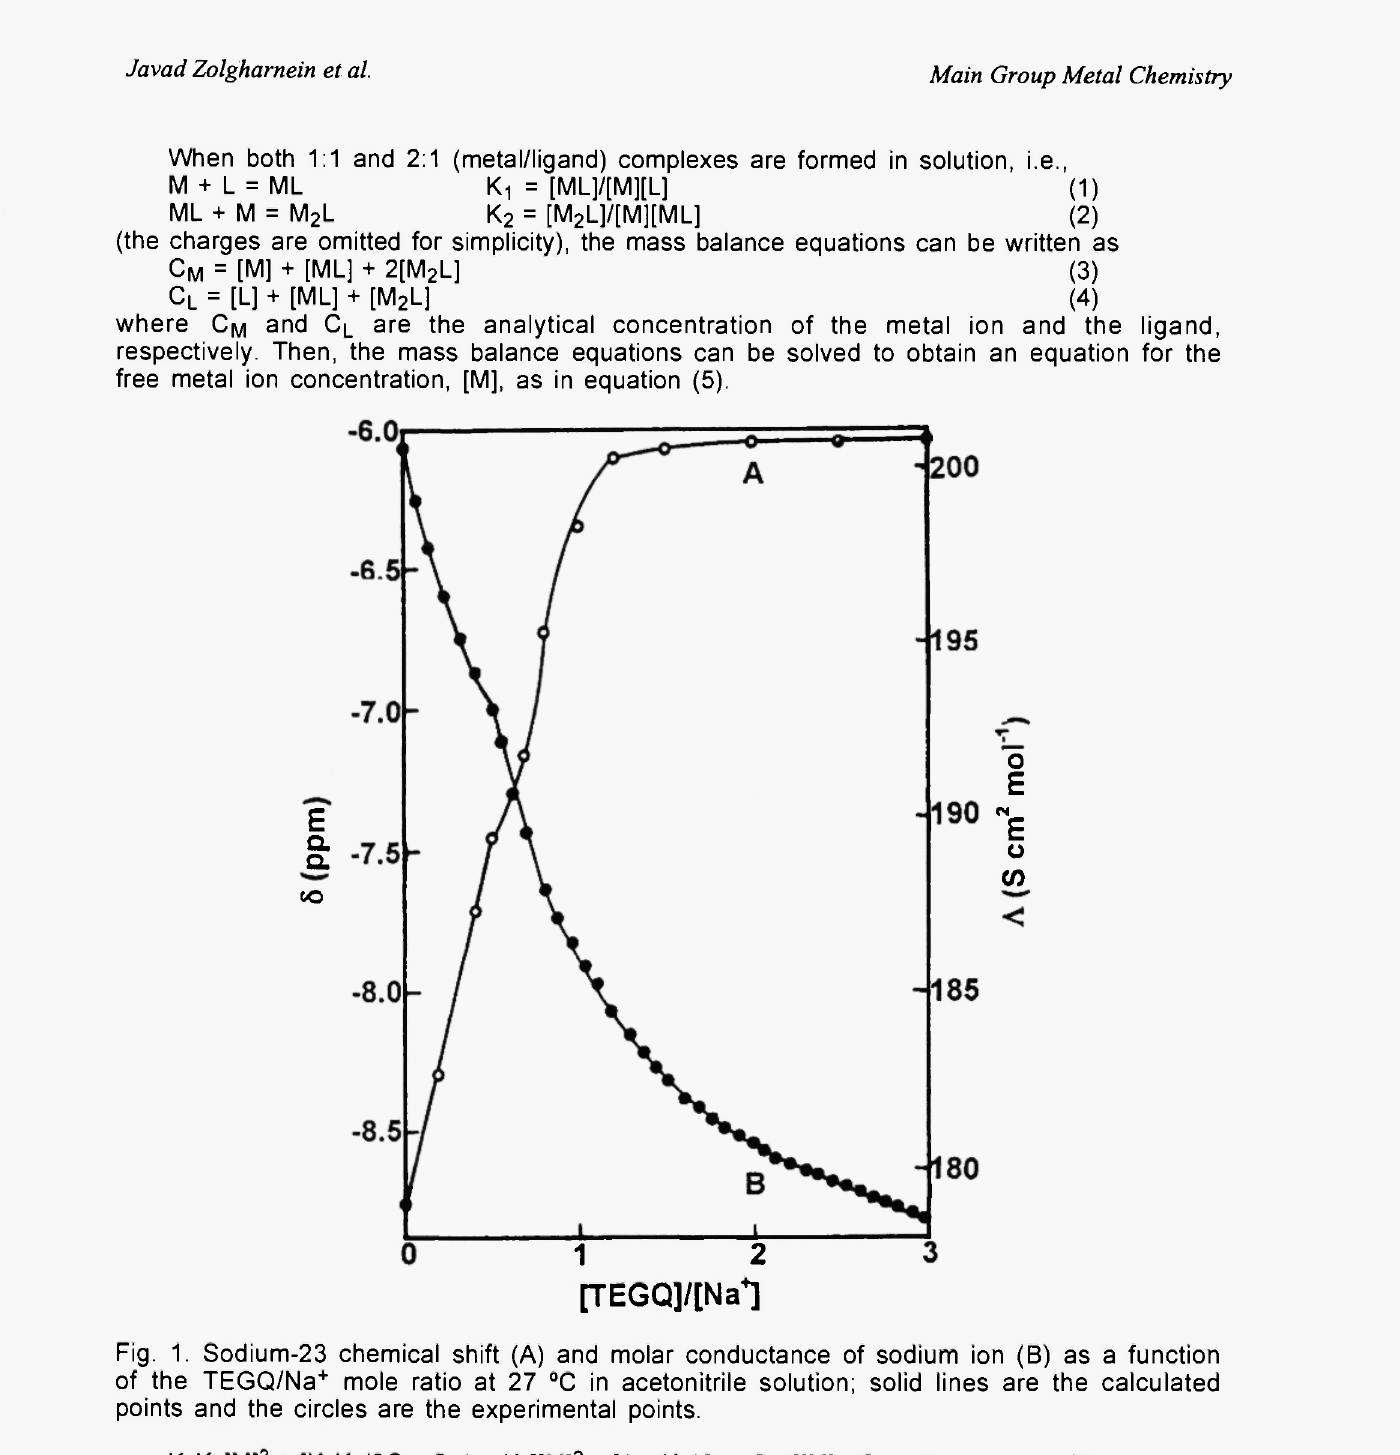
Fig. 1. Sodium-23 chemical shift (A) and molar conductance of sodium ion (B) as a function of the TEGQ/Na + mole ratio at 27 °C in acetonitrile solution; solid lines are the calculated points and the circles are the experimental